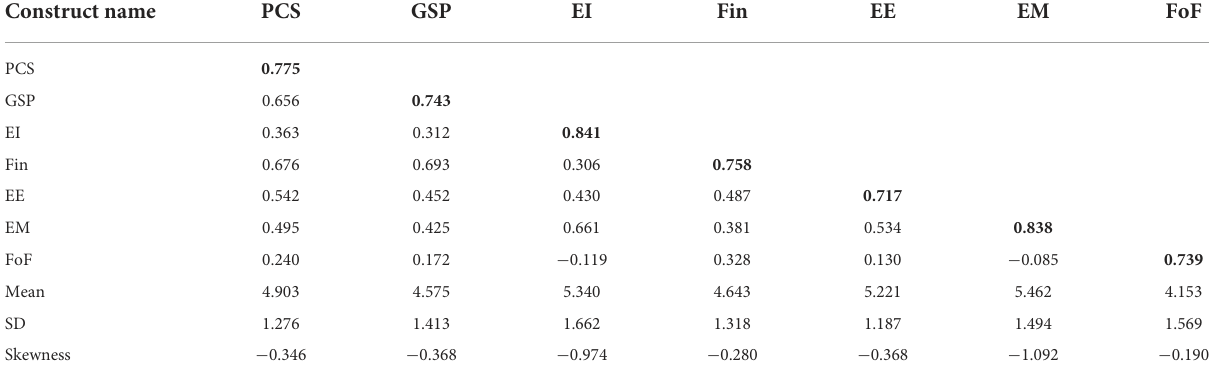
TABLE 3 Correlations, divergent validity, and descriptive